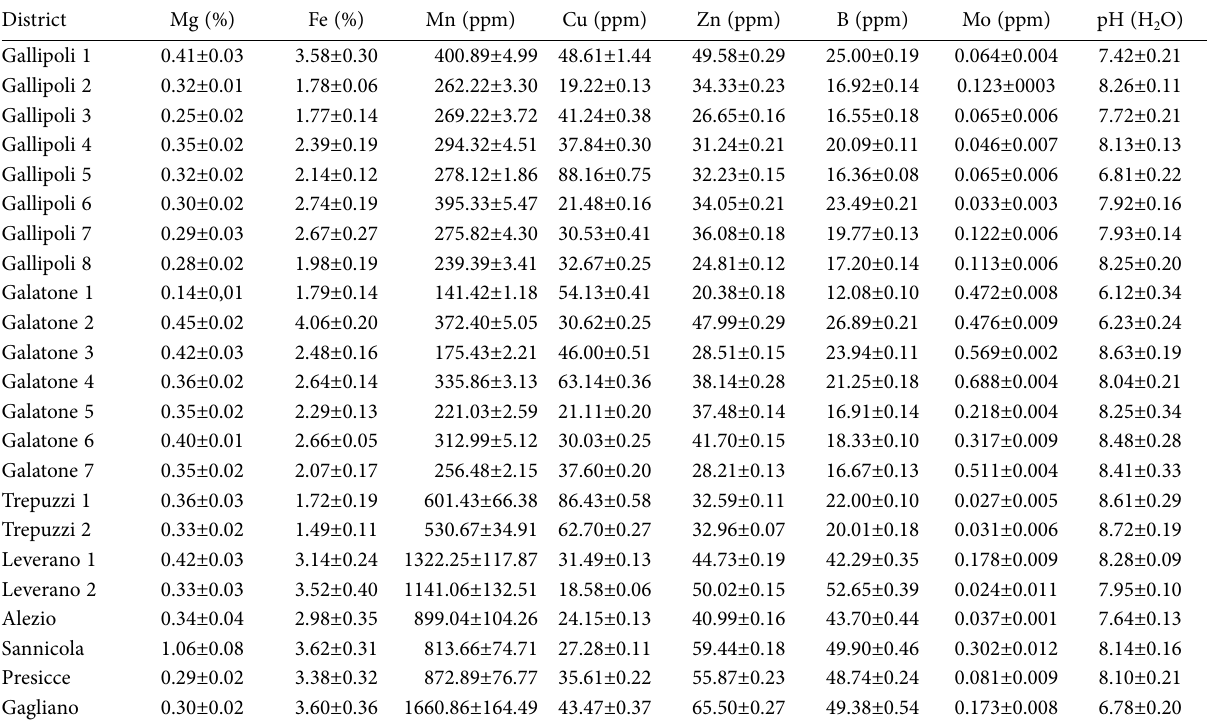
Table 1. Magnesium and micronutrient contents, and pH values for soils sampled in Gallipoli, Galatone and other districts of Lecce prov- ince, from farms with olive quick decline syndrome and infections by Xylella fastidiosa subsp. pauca . For each farm, means (± standard deviation) are presented for 12 samples collected in three different